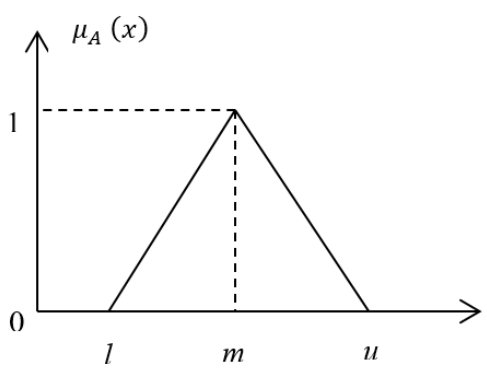
Figure 5. Membership function of a triangular fuzzy number M = ( 1 , m , u ).